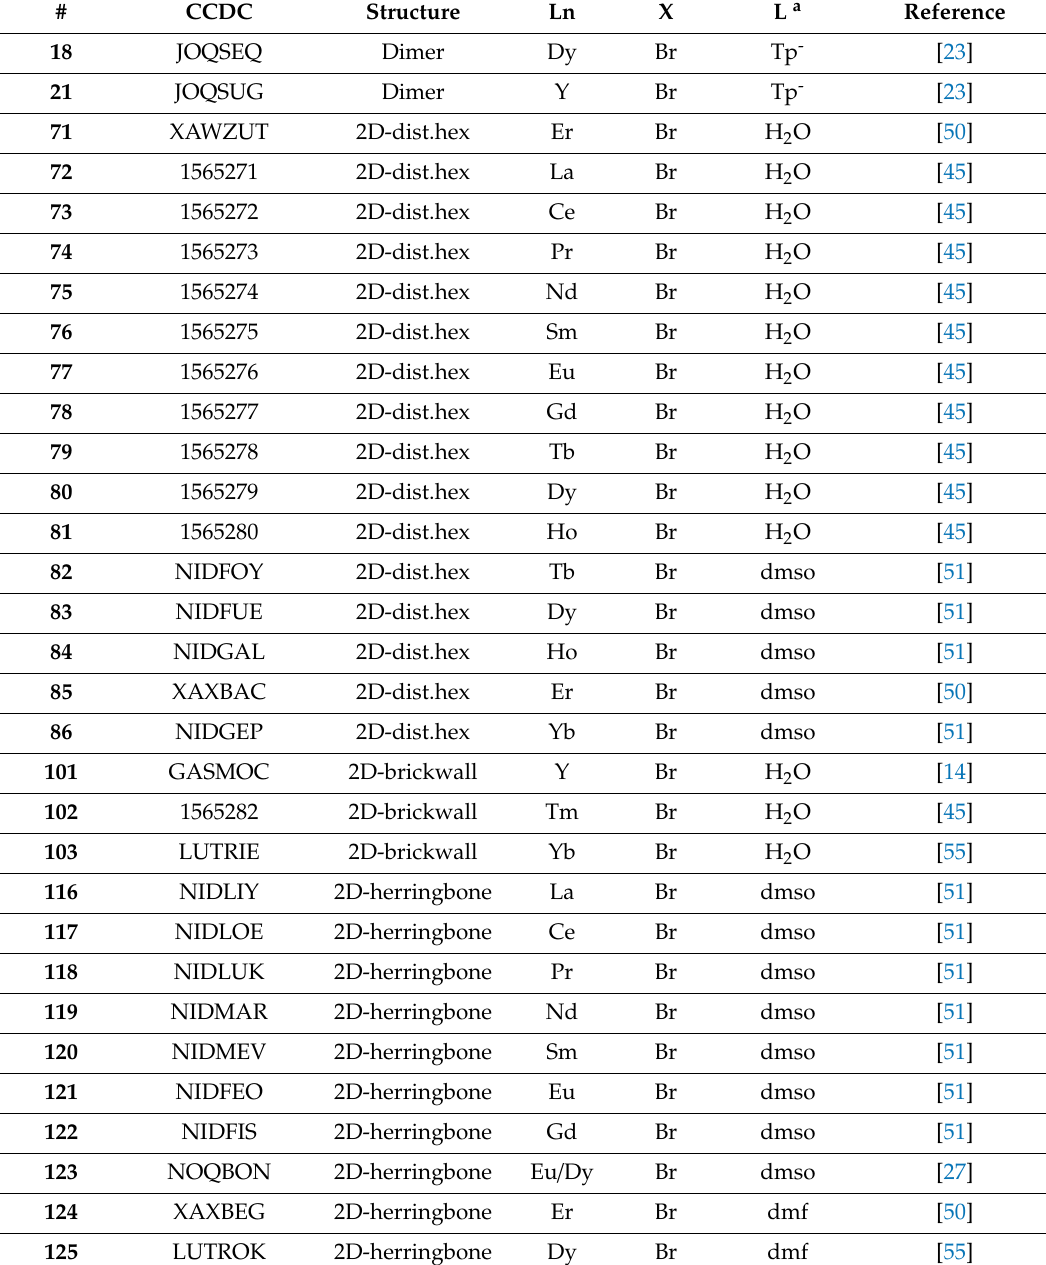
Table 10. Structurally characterized Ln compounds with